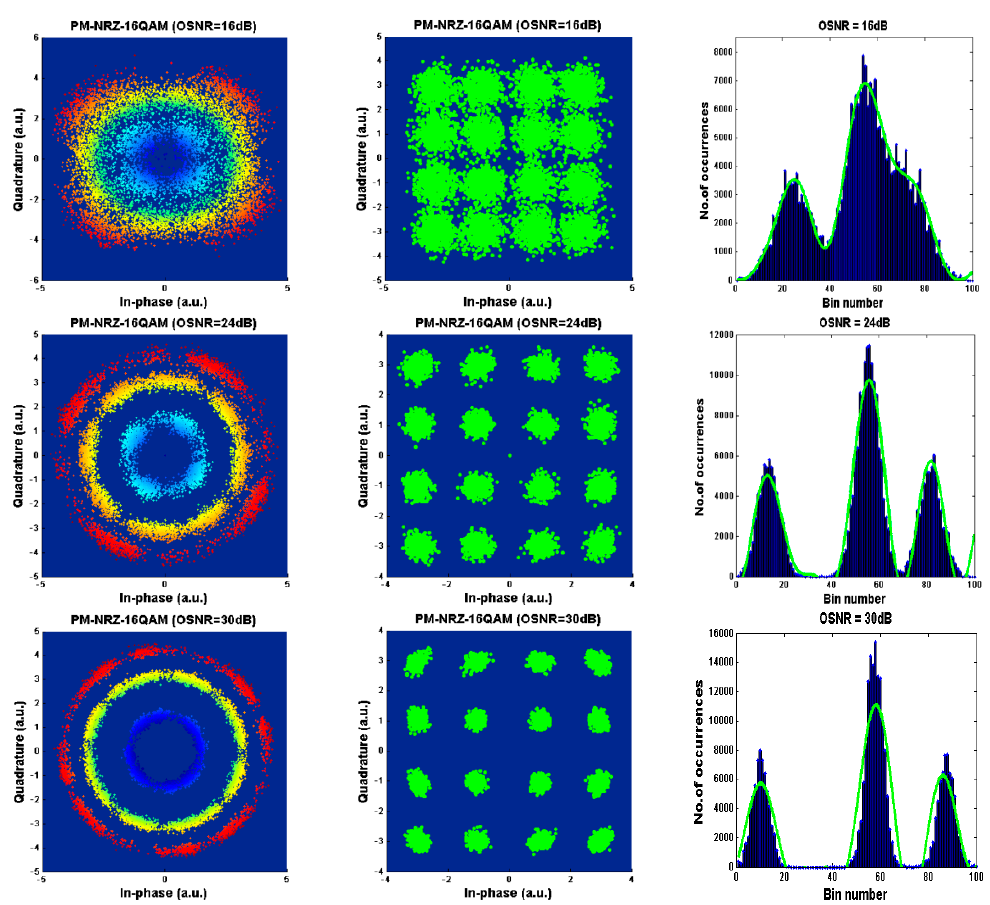
Figure 3. Constellation diagrams and amplitude histograms with Fourier fitting at three different OSNRs for PM-NRZ-16QAM signals.